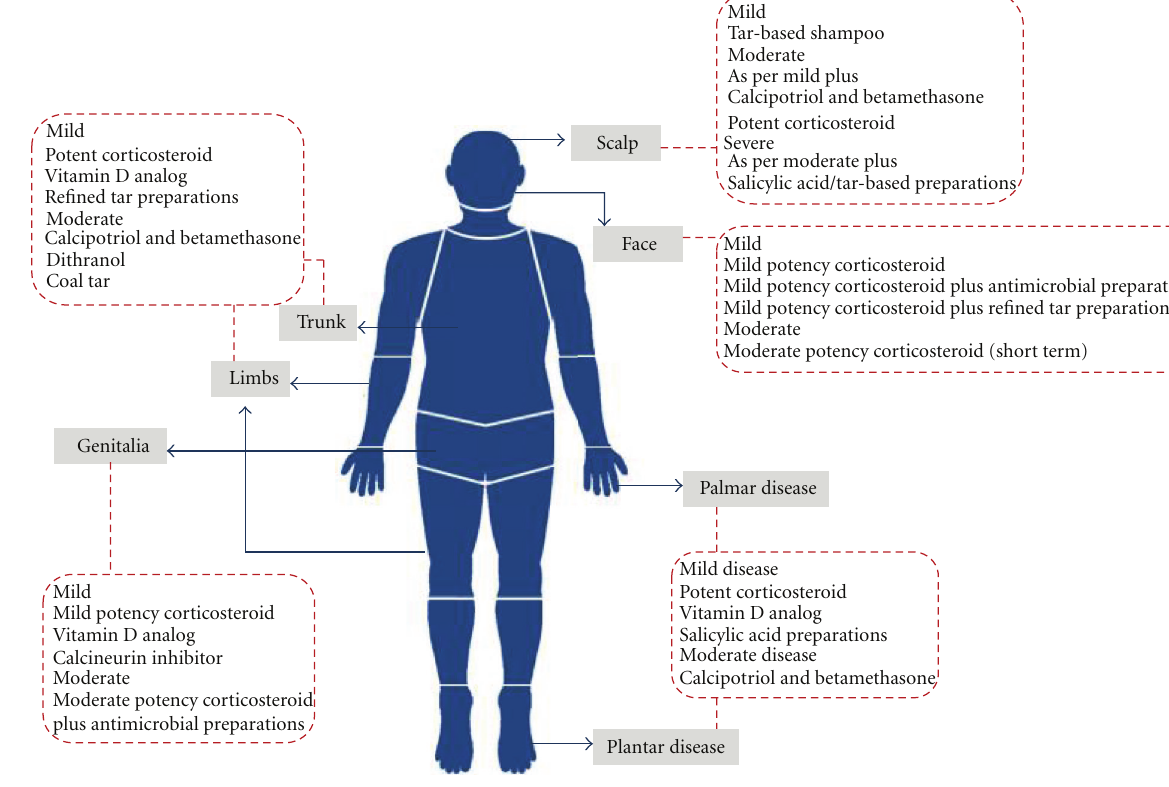
Figure 1: Topical therapy for management of